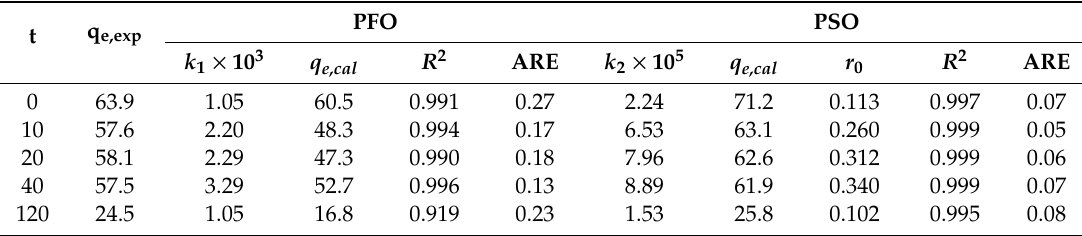
Table 5. Pseudo-first-order and pseudo-second-order kinetic parameters for the adsorption of